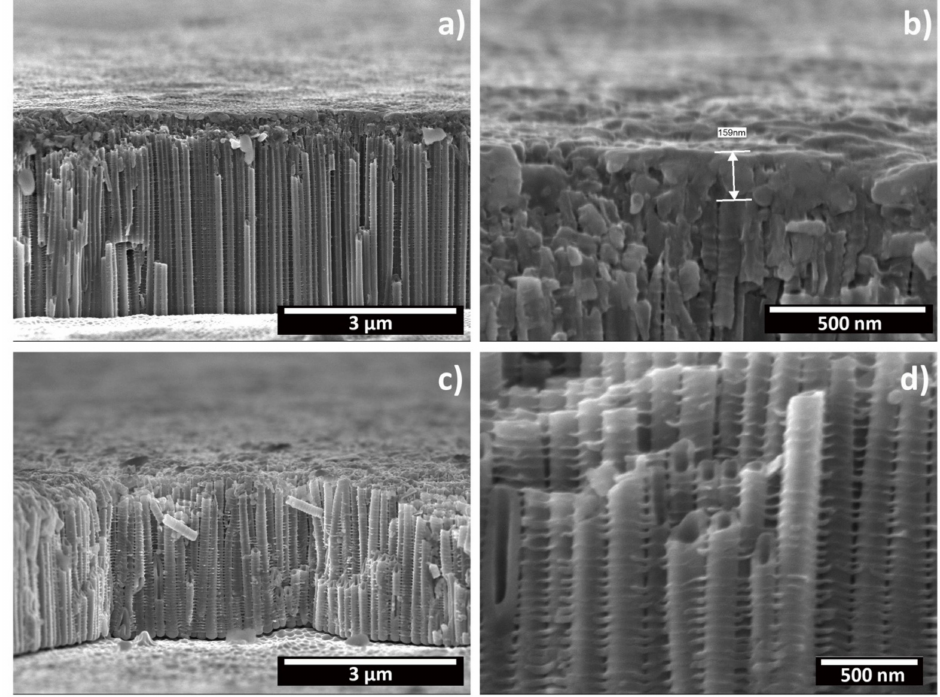
Figure 10. FESEM micrographs depicting the oxide layer produced on CP-Ti through electrochemical anodization at 40 V for 1 h ( a , b ) or 6 h ( b , d ) in cross section. ( a , c ) General view, ( d ) a detailed view of the initiation layer and tube tops, and ( d ) a detailed view of the tube side-wall